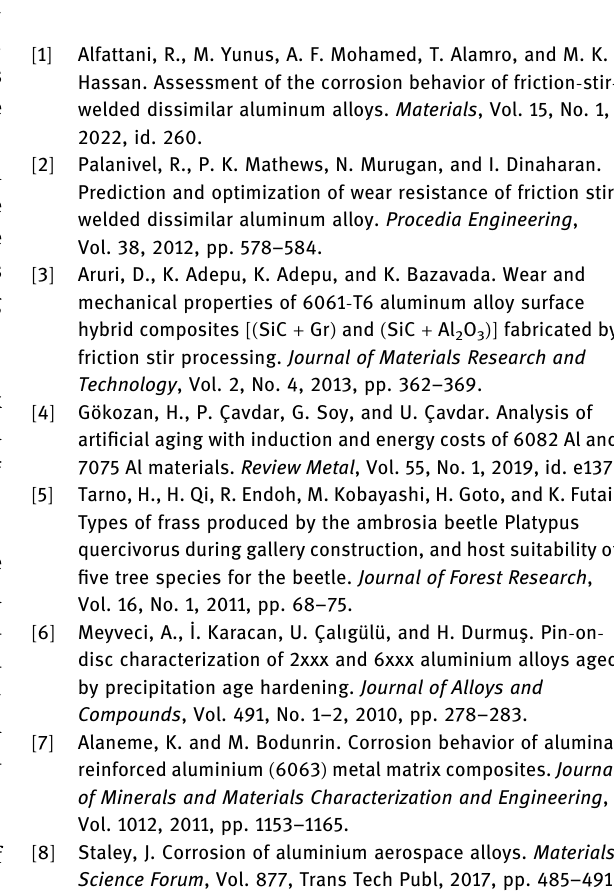
region ) particles, and splits have arisen in the trench region of the granules.